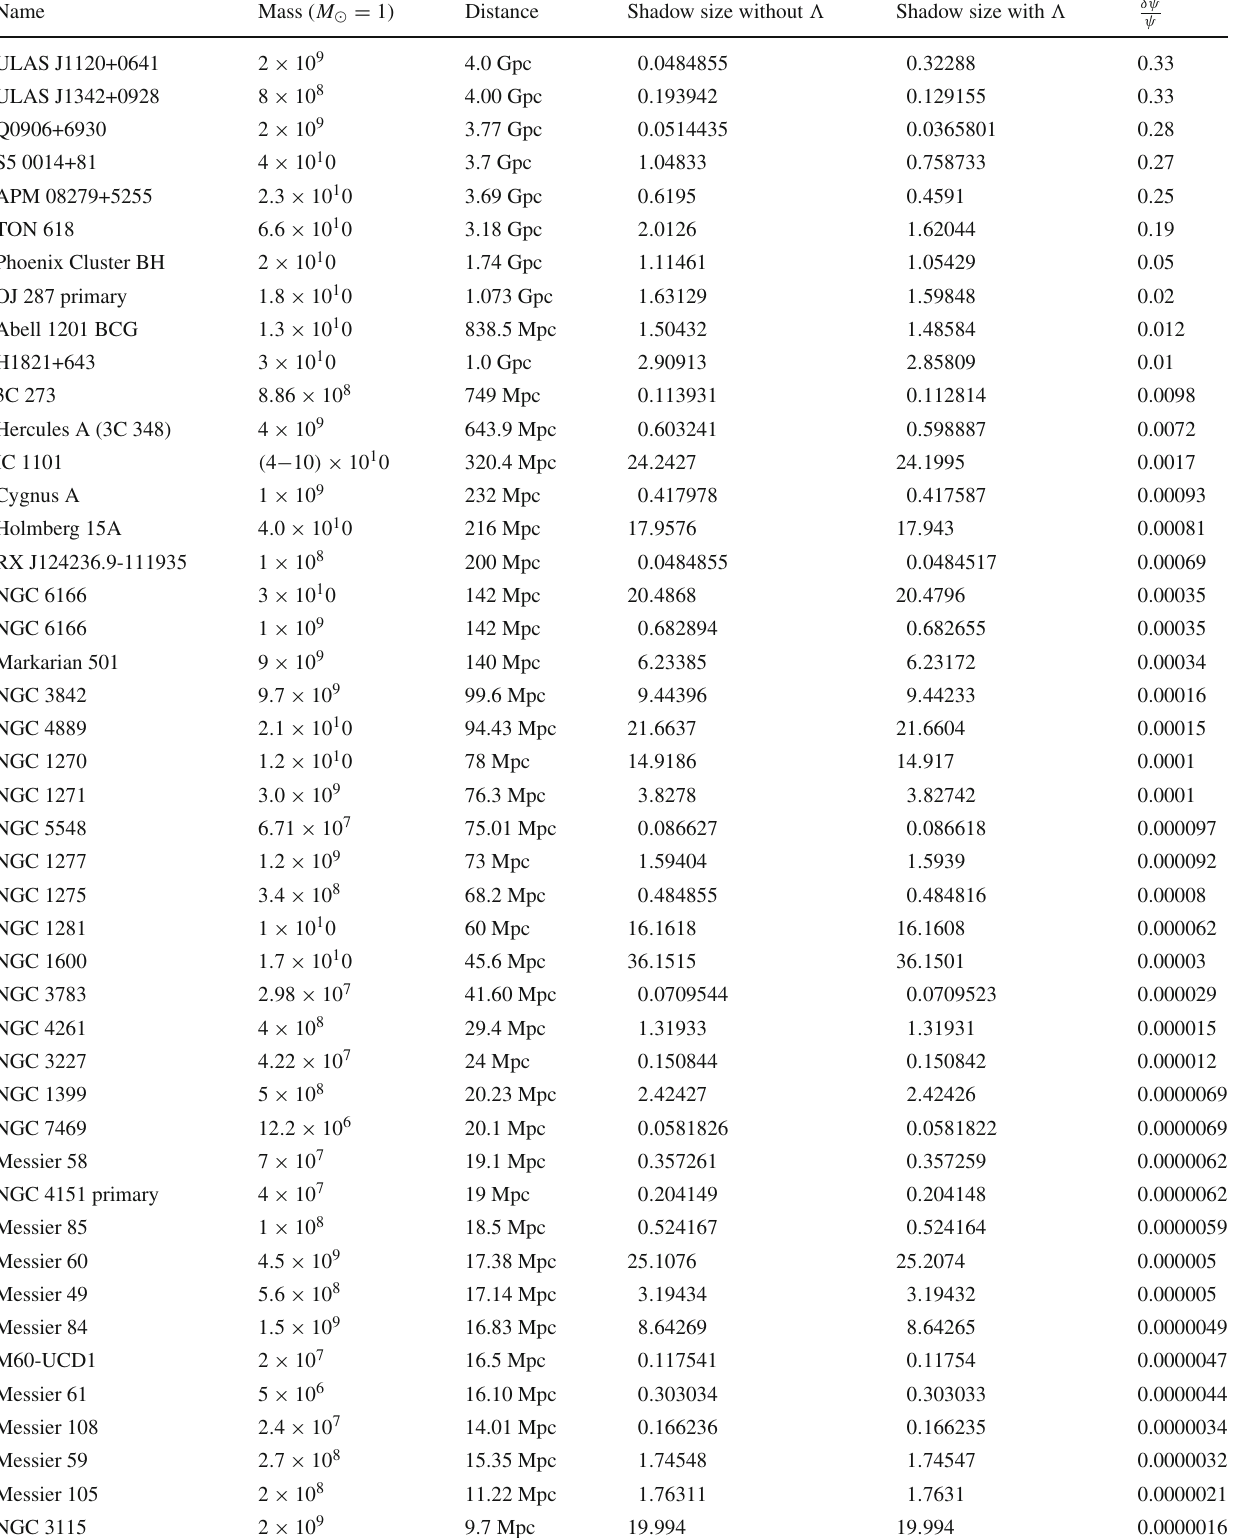
Table 1 Supermassive black holes with known mass and distance. In this table, we compare the effect of the cosmological constant on their shadow size in microarcseconds. The fractional difference could be of order 3